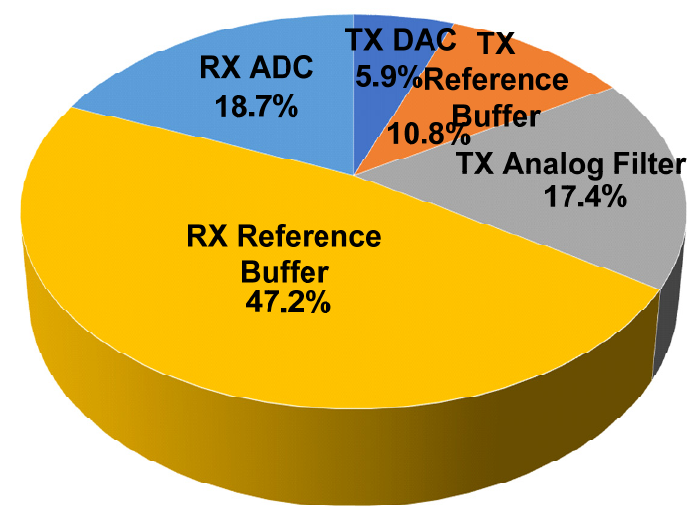
Figure 8. Power breakdown of our EIS SoC at 50 MHz.